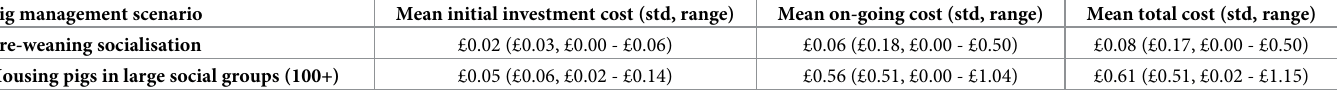
Table 3. Mean (standard deviation, range) initial investment cost, on-going cost and total cost of implementing each pig management scenario as estimated by farmers. Pig management